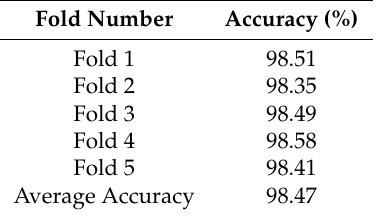
Figure 8. Illustration of the k-fold validation. Table 3. Results of fivefold experiments using our recorded datasets combined from all three